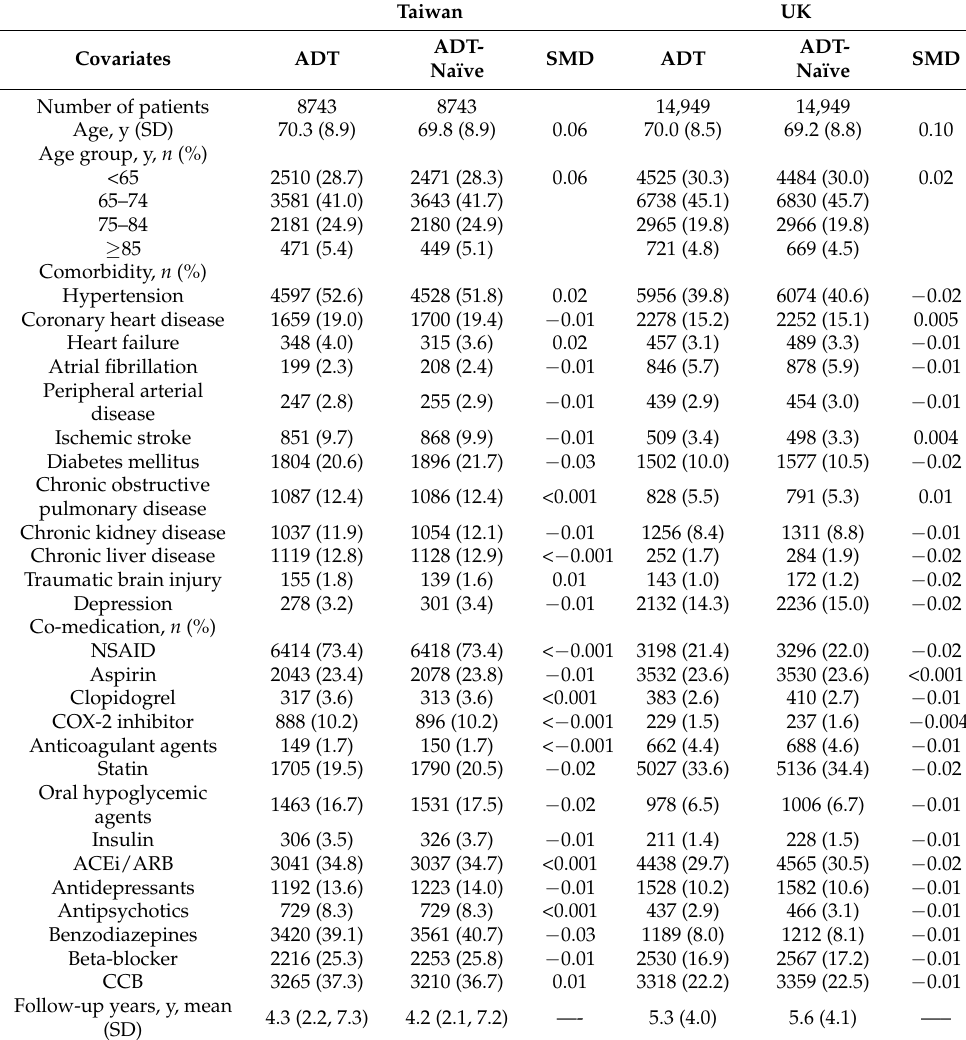
Table 1. Characteristics of the study